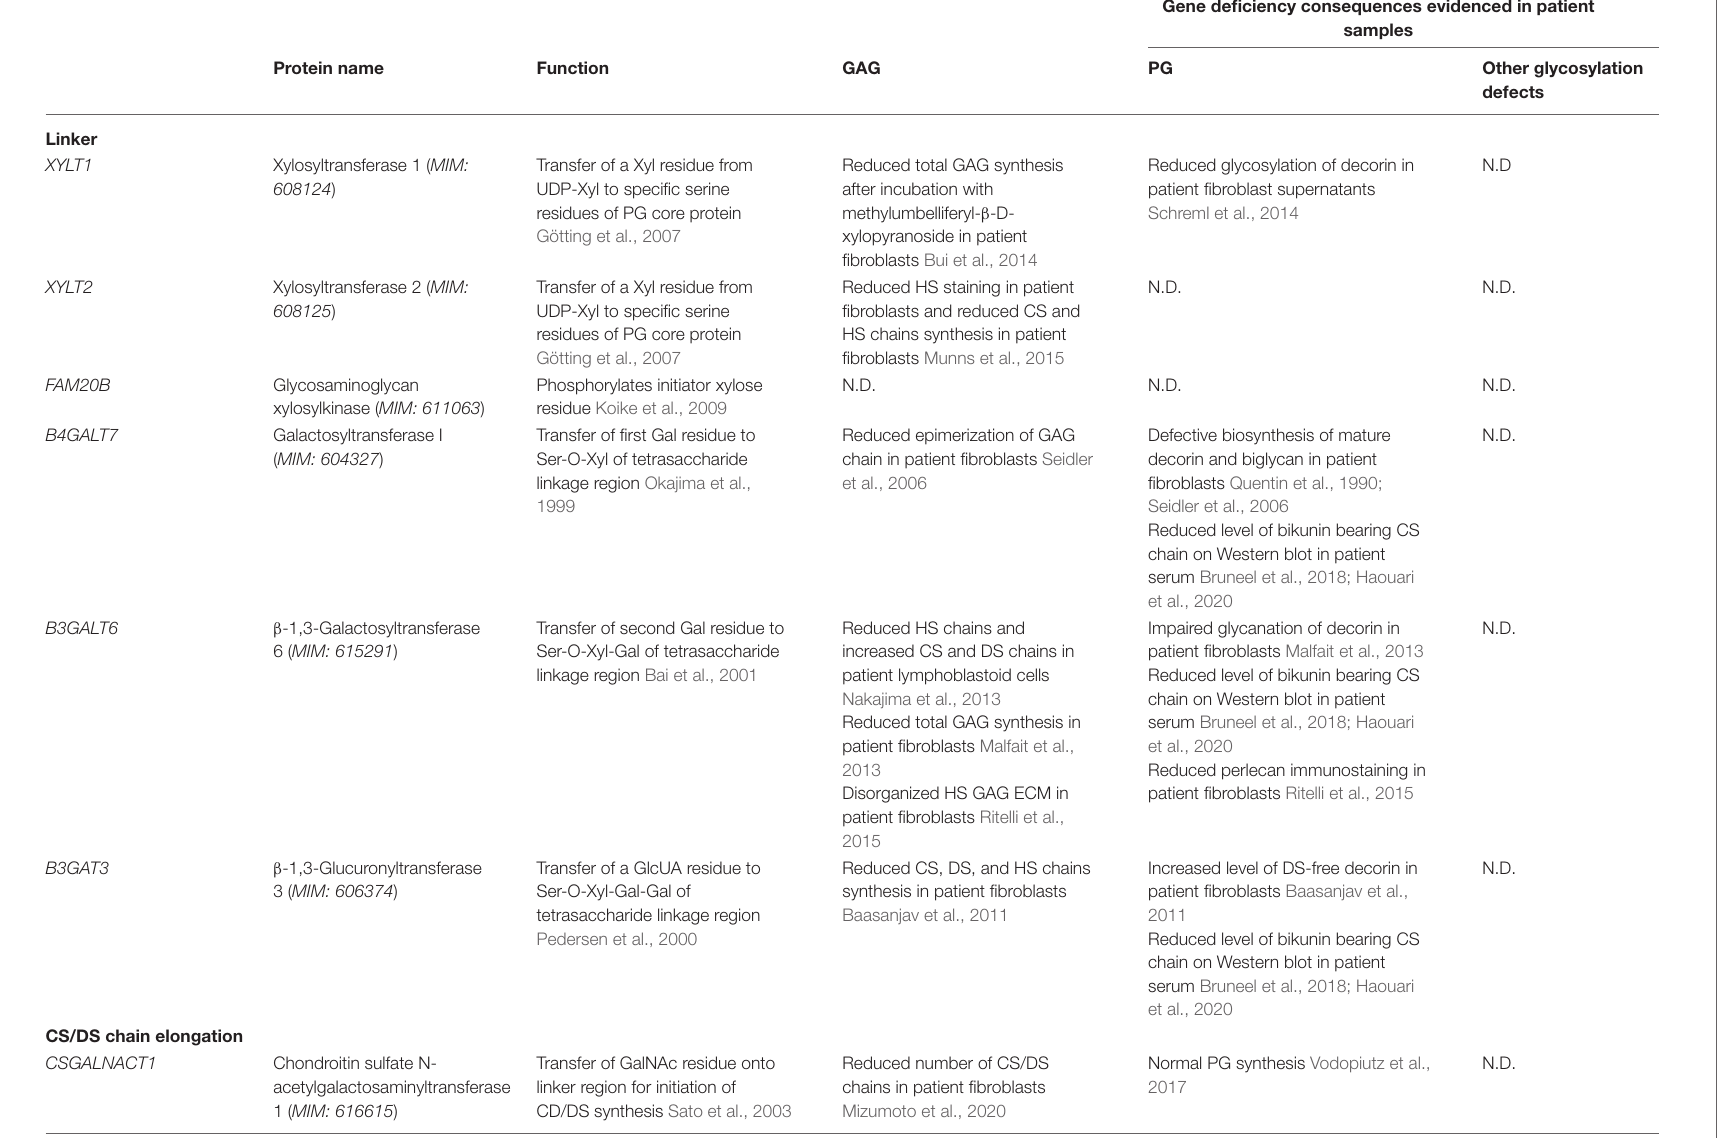
TABLE 2 | GAG biosynthesis enzymes implicated in defects observed in patient